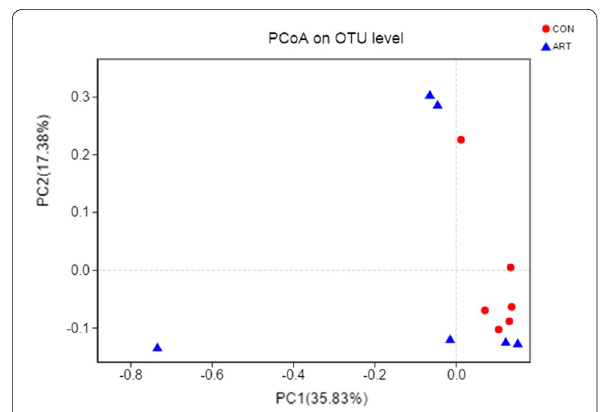
Fig. 1 Principal coordinate analysis (PCoA) of milk microbial communities from lactating cows fed TMR supplemented with 0 (CON) and 120 g/d artemisinin (ART), n =